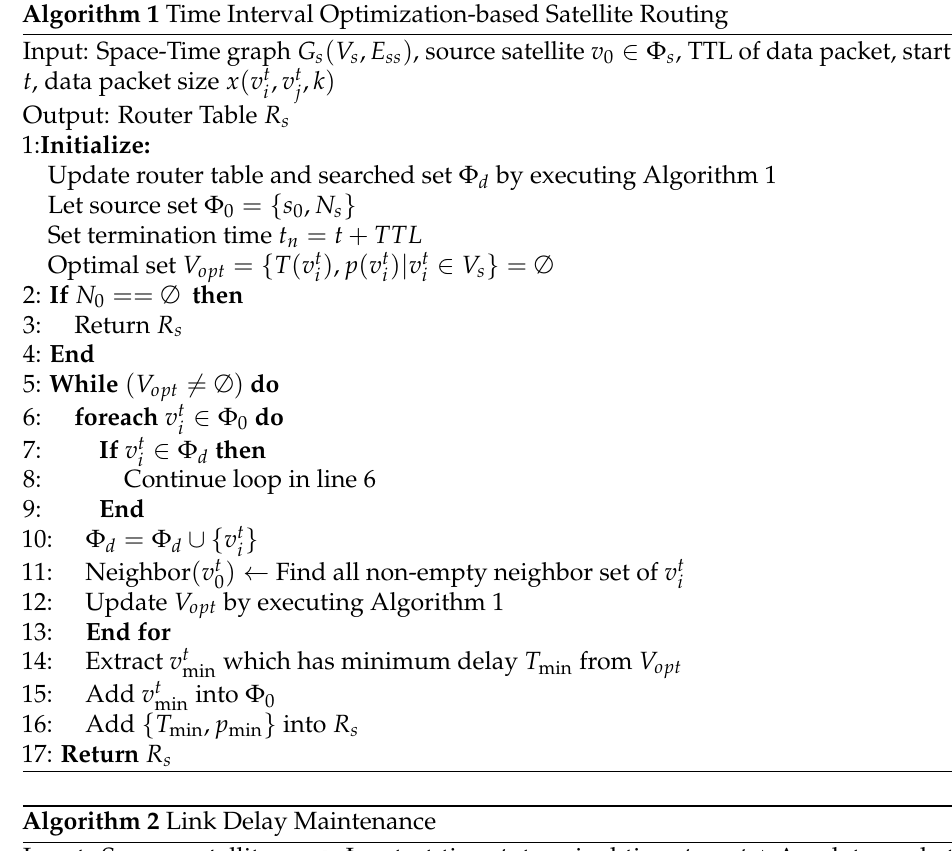
Algorithm 2 Link Delay